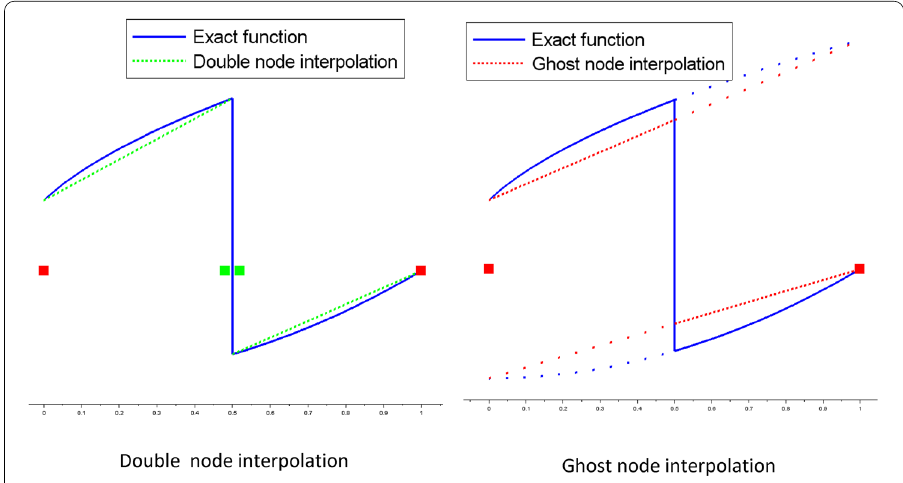
Fig. 31 Comparison between double node interpolation and ghost node interpolation for an arbitrary function. The ghost node method uses the same element to interpolate both extrapolated branches. In contrast, the double node refines the mesh around the discontinuity. Thus, the double node is twice more accurate than the ghost node, but it requires a meshing of the interface (a strategy not relevant in the framework of